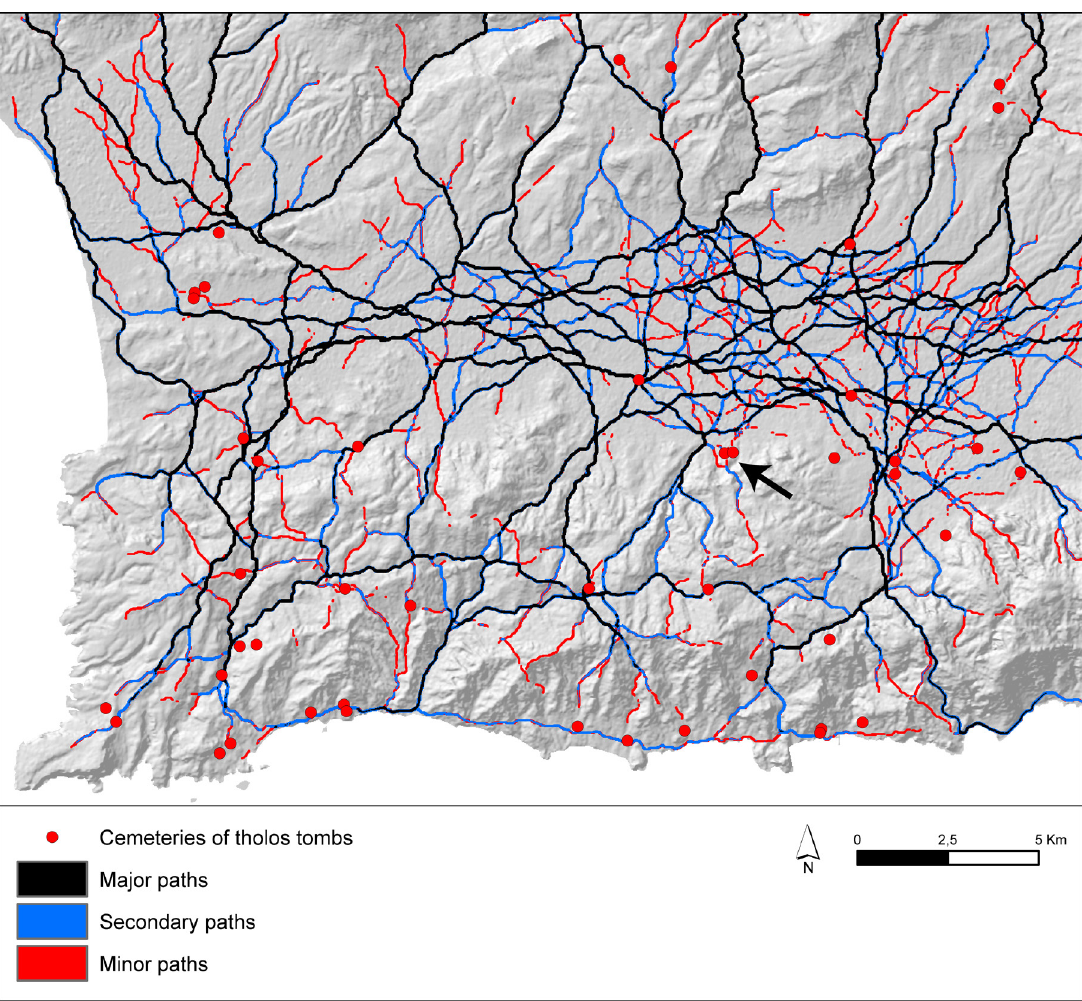
Figure 12. Hierarchical communication network of Prepalatial and Protopalatial Crete – calculated based on the distribution of circular tombs. The location of Apesokari is indicated by the black